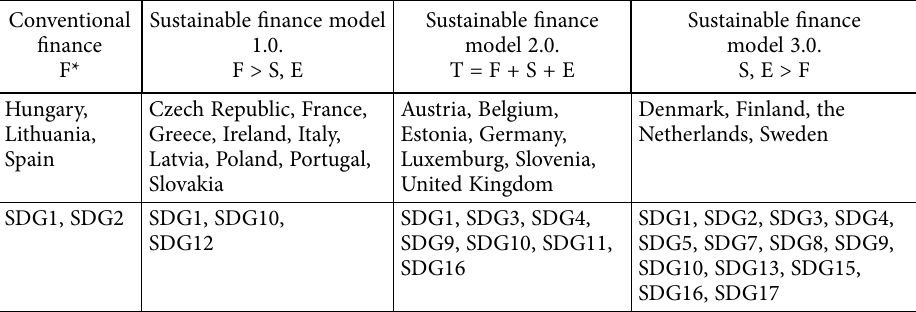
Table 6. Relationship between sustainable finance model and SDGs Conventional Sustainable finance model finance 1.0. F*